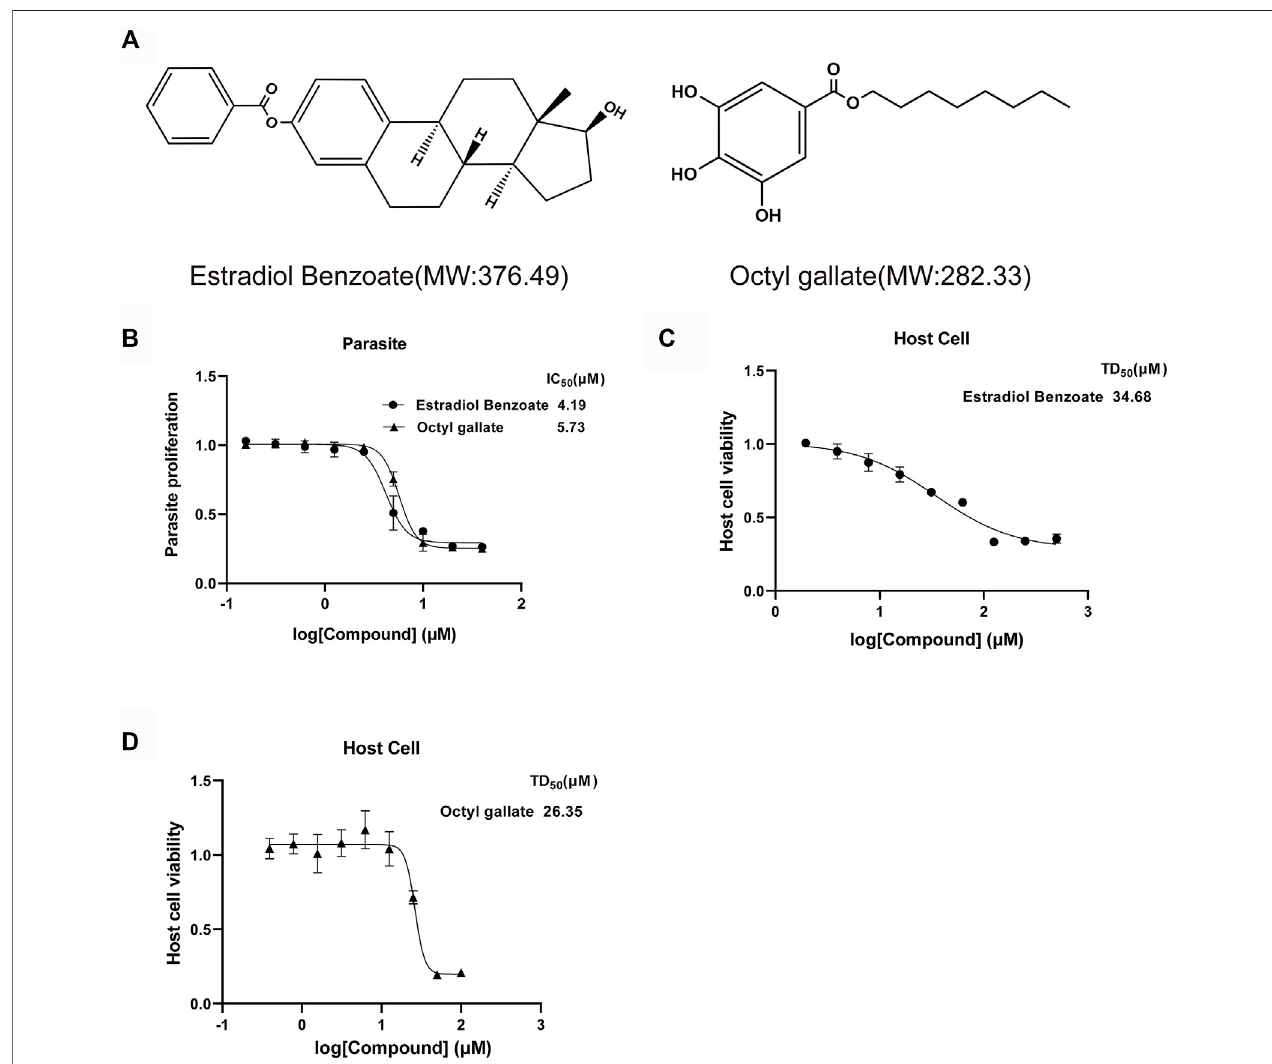
FIGURE 2 | Estradiol benzoate and octyl gallate have dose-dependent inhibitory effect on T. gondii growth. (A) Molecular structures and molecular weights of estradiolbenzoate and octylgallate. (B) Dose – responseresponse curves and IC 50 values forestradiolbenzoate and octylgallate.RH-2F tachyzoite-infected HFFs were incubated with serial concentrations (0 – 50 μ M) of the test compounds, and β -Gal activity was measured to evaluate parasite growth. (C) TD 50 values of estradiol benzoateonHFFcells.HFFcellswereincubatedwithvariousconcentrations(0 – 500 μ M)ofestradiolbenzoatefor72 h,anditscytotoxicitywasevaluated. (D) TD 50 values of octyl gallate on HFF cells. HFF cells were incubated with various concentrations (0 – 100 μ M) of octyl gallate for 72 h, and its cytotoxicity was evaluated.